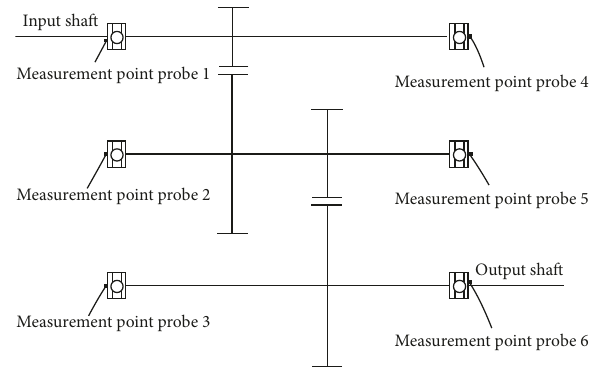
Figure 2: Measurement points